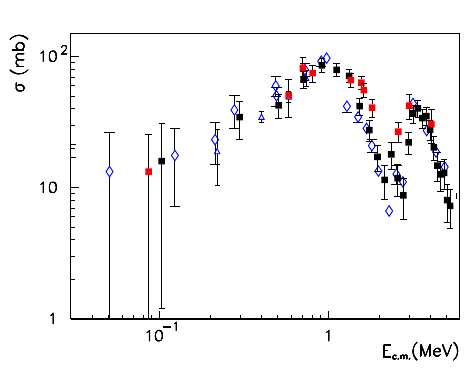
Figure 4: 7 Be(n, α ) cross section obtained with the THM using the 7 Li(p, α ) 4 He mirror reaction (full red squares) and 3 He THM breakup data (full black squares) [47]. Other data compiled in Ref. [44] are displayed as empty blue diamonds. Additionally, data from Ref. [46] are dis- played as empty blue